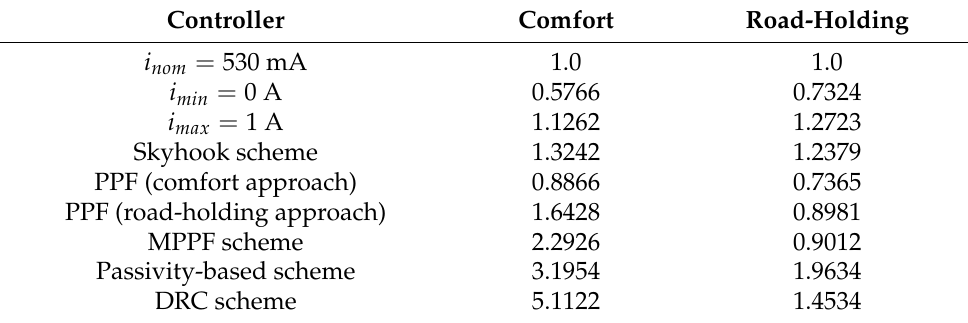
Table 3. Normalized performance criteria comparison for different damping control.